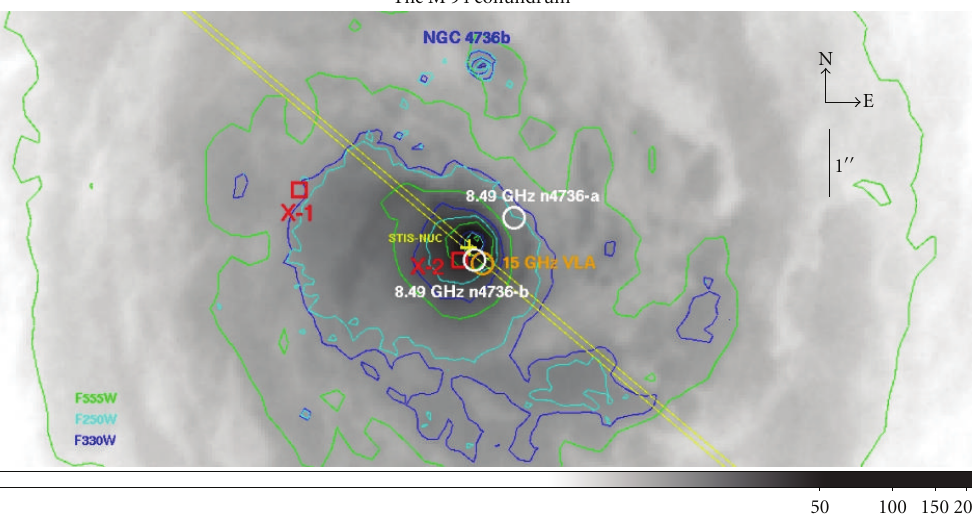
Figure 3: The mosaic-ed F555W (V-band; combination of 5 WFPC2 images taken at two di ff erent epochs) image of the NGC4736 nucleus, with intensity contours overlaid (green). The position of the STIS-nucleus is indicated (by the yellow slit) along with the locations of the 2 most luminous and closest to the nucleus hard X-ray sources, X1 and X2, as detected with Chandra (red squares), along with the position of the 15GHz VLA radio core ([46], orange circle), and those of the two radio compact sources detected by K¨ording et al. [31] (white circles). The blue and cyan contours correspond to the F330W and F250W observations from Maoz et al. [29]; note the presence of NGC 4736b, ≈ 2 . (cid:5)(cid:5) 5 to the north of the nucleus. The absolute astrometry is good to within 0 . (cid:5)(cid:5) 2 (pixel size is 0 . (cid:5)(cid:5) 05 for F555W, and 0 . (cid:5)(cid:5) 025 for F250W and